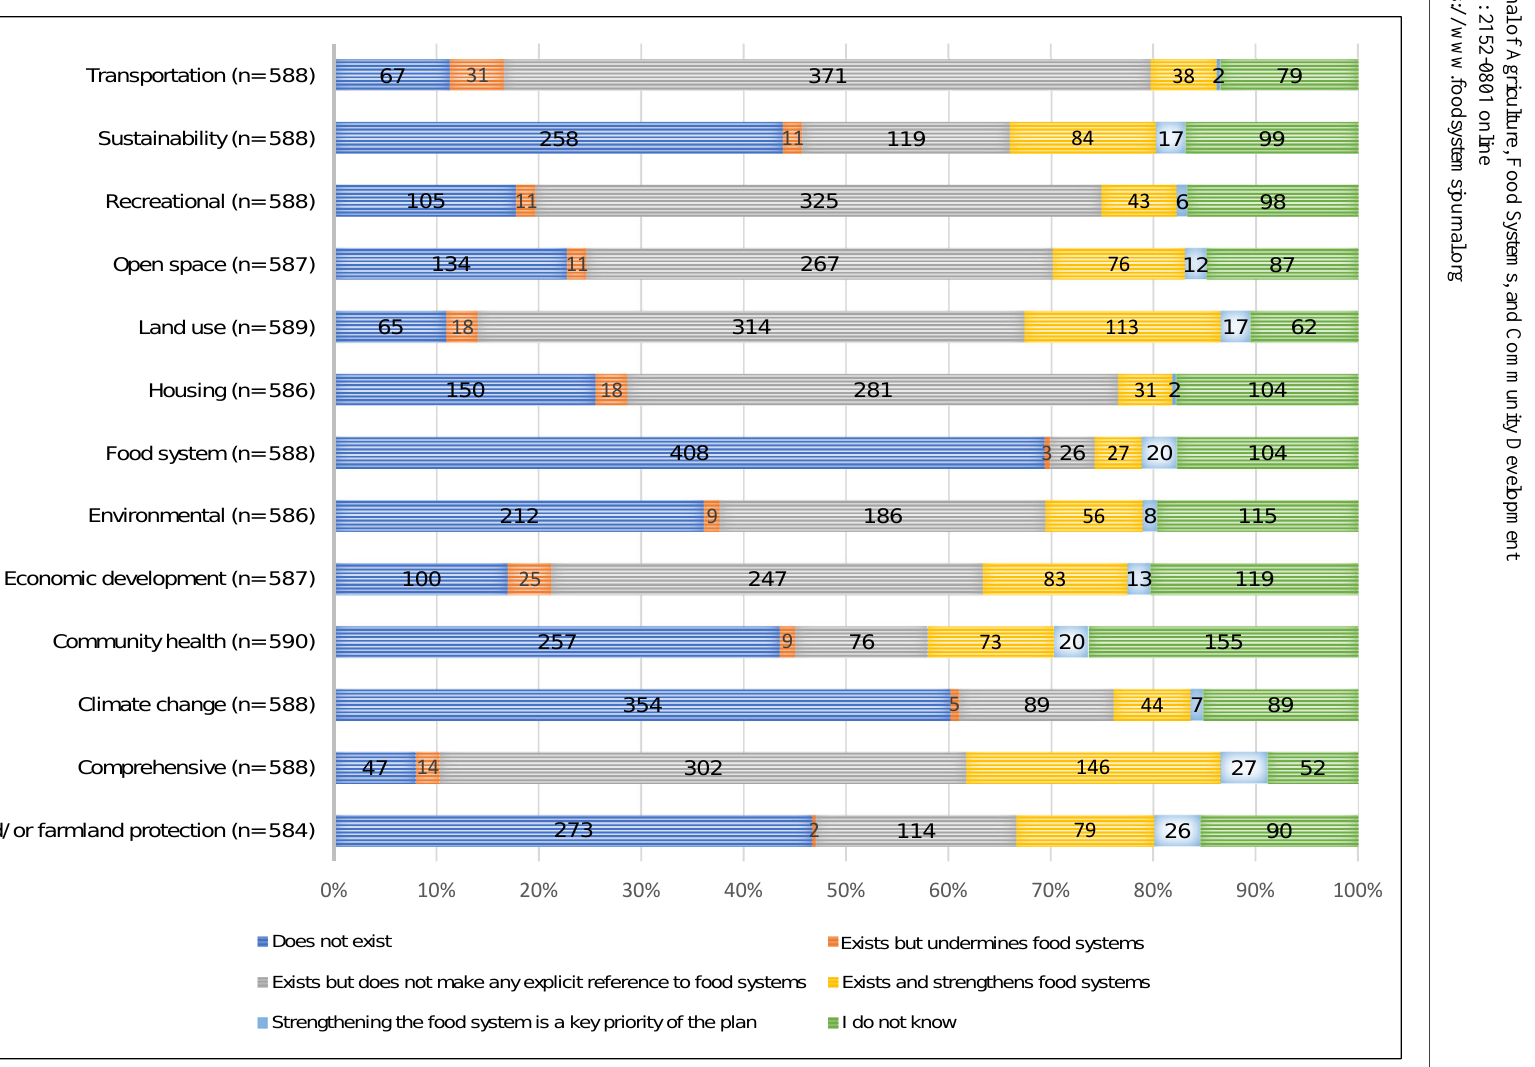
V Figure 4. Formal Plans Adopted by Local, Regional, and Metropolitan (LRM) Governments that Address Food Systems o l